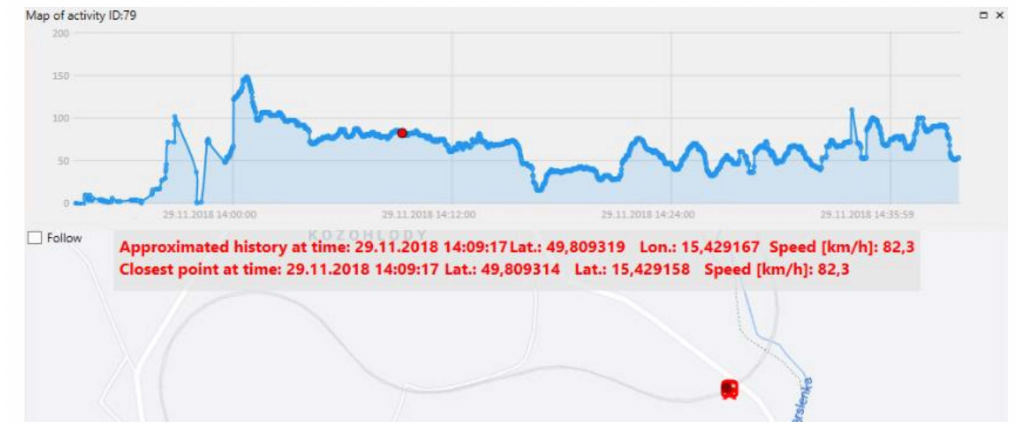
Figure 22. The speed profile of the train and its map location at selected time